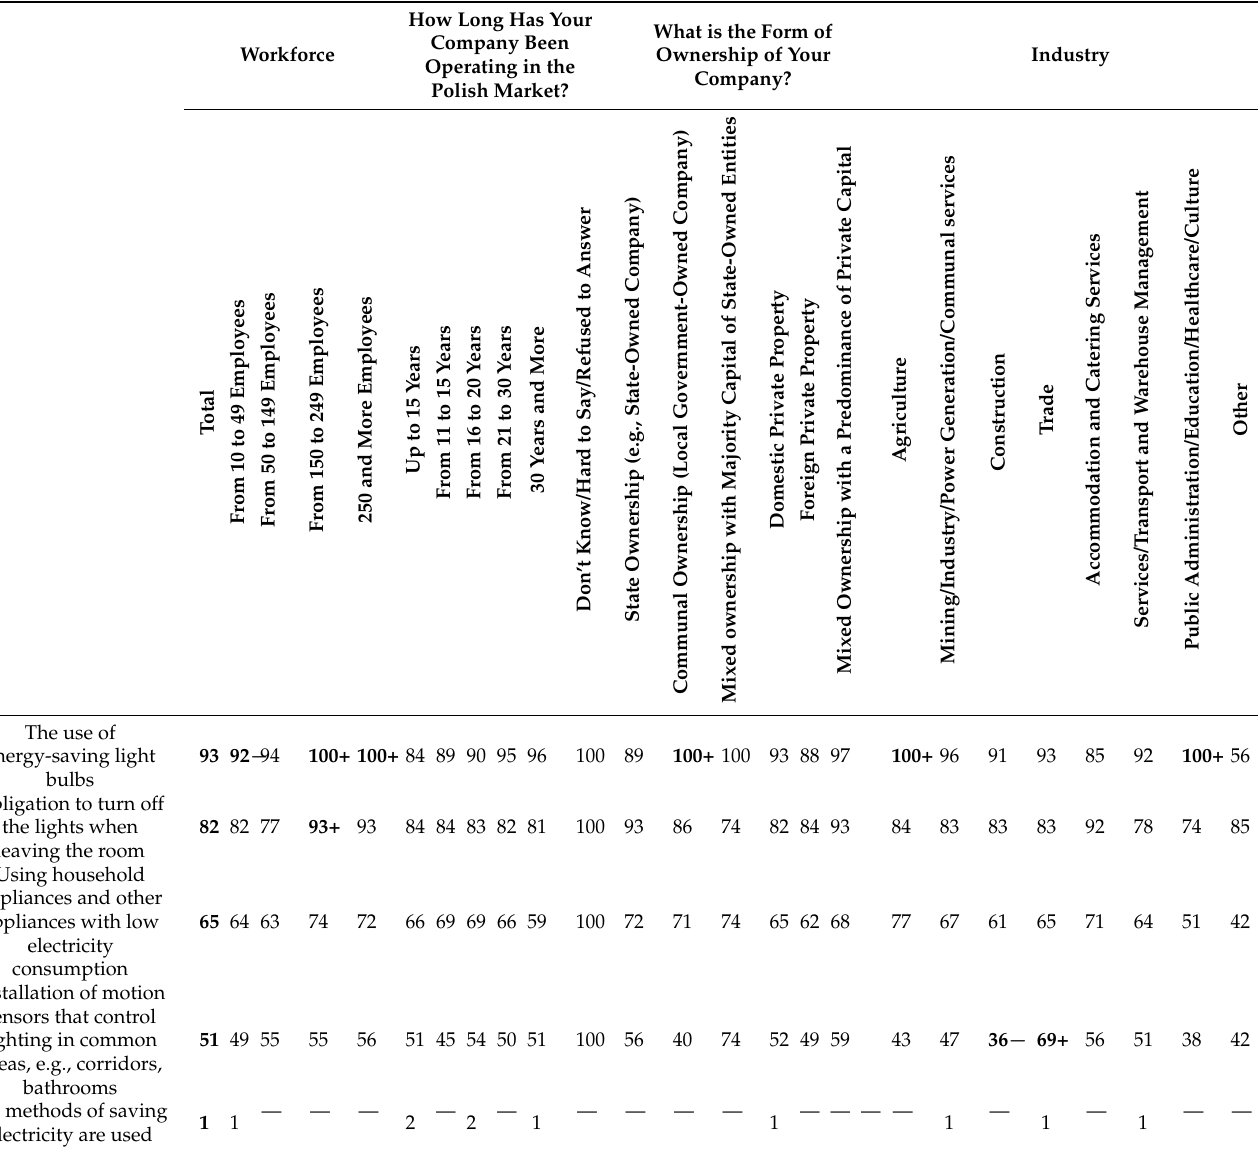
Table 4. Methods of saving electricity applied in the workplace (answers in percentage points). Are the following methods of saving electricity used in your workplace/company? How Long Has Your What is the Form of Company Been Workforce Ownership of Your Operating in the Company? Polish Market?